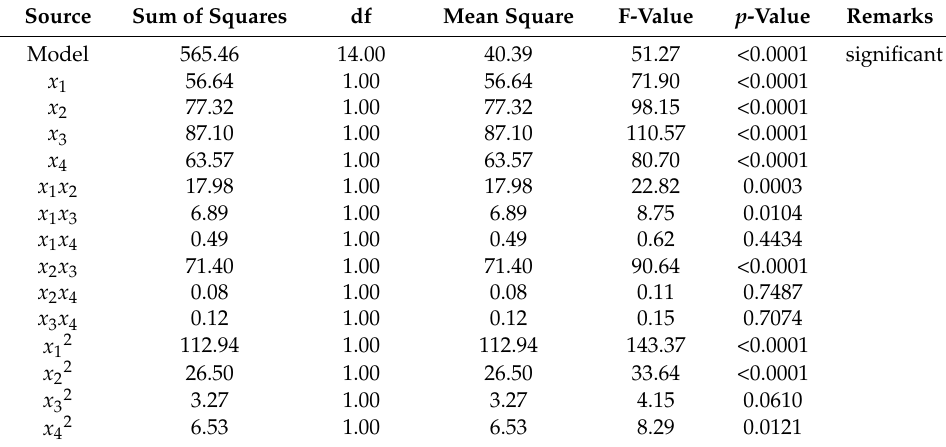
Table 2. The results of ANOVA for the second-order polynomial equation.